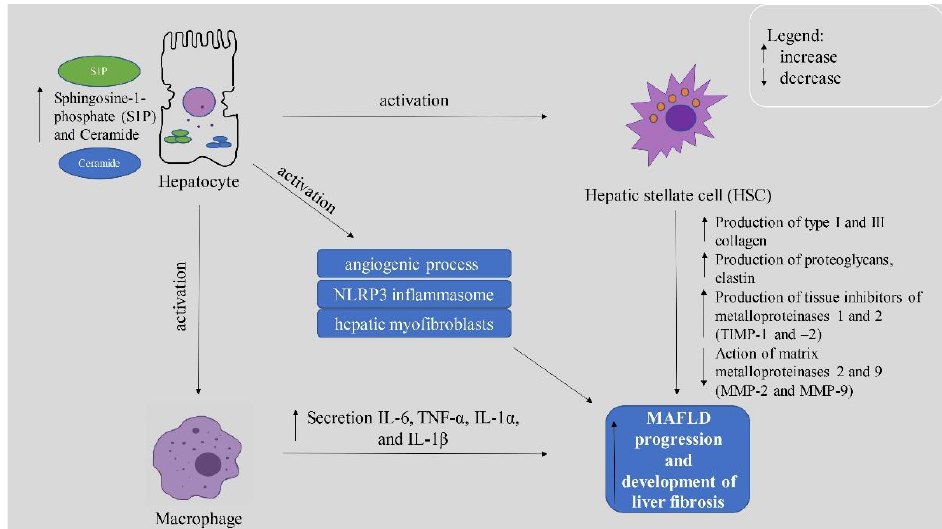
Figure 2. The effect of Sphingosine-1-phosphate (S1P) on the MAFLD progression to liver fibrosis. S1P: Sphingosine-1-phosphate, HSC: Hepatic stellate cell, TIMP-1 and -2: tissue inhibitors of metalloproteinases 1 and 2, MMP-2 and MMP-9: matrix metalloproteinases 2 and 9 .